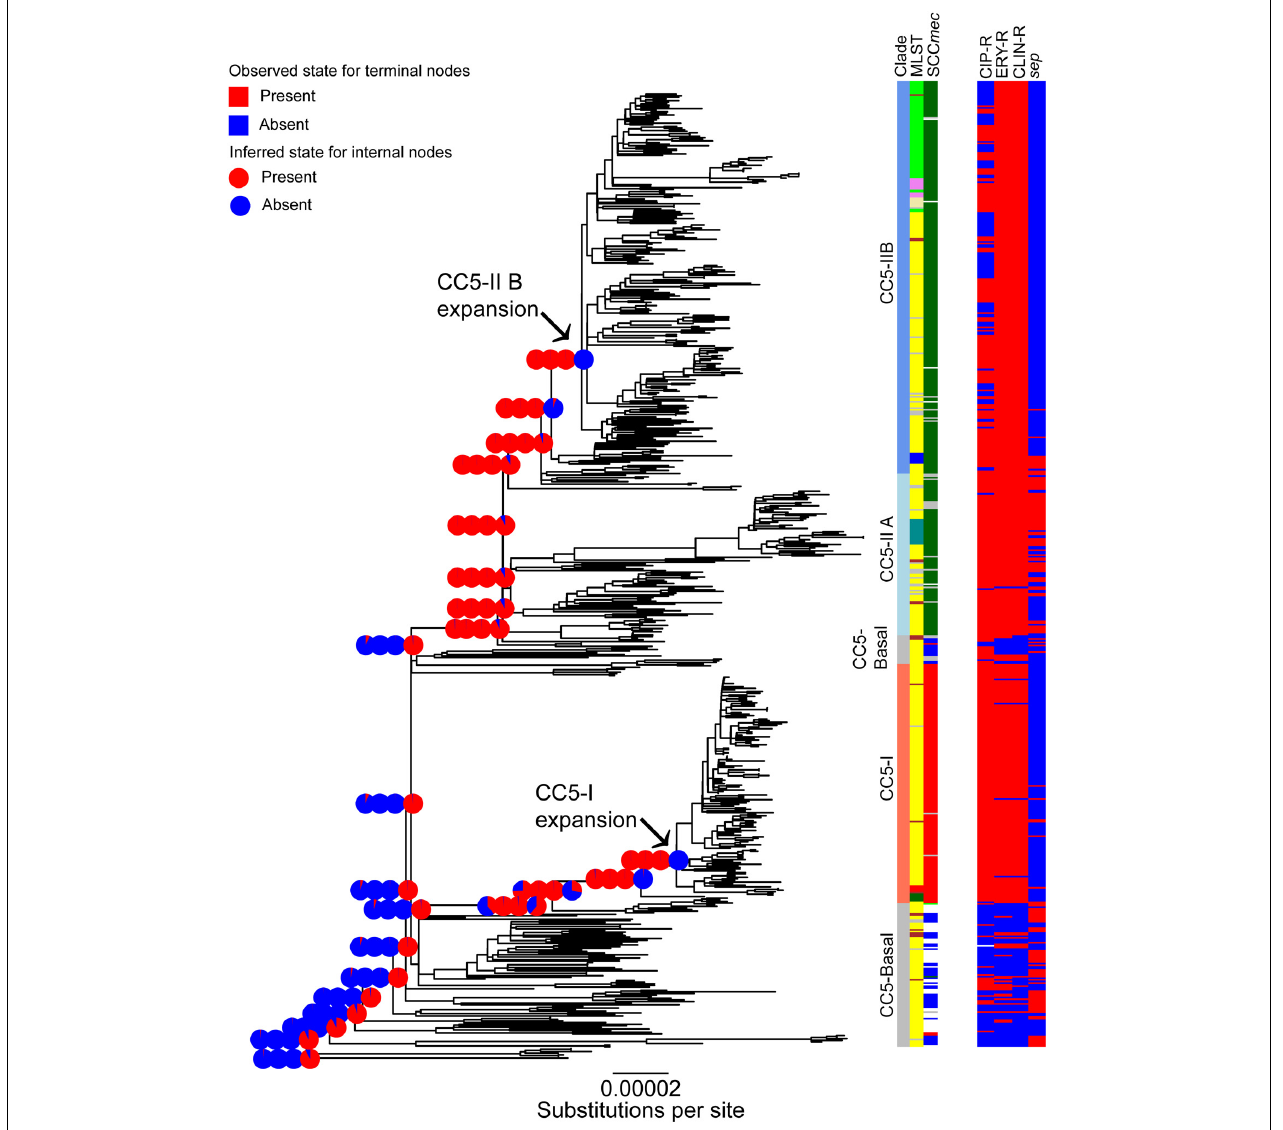
FIGURE 2 | Convergent evolution within CC5. The ML phylogeny of Figure 1 is shown. The major clades, multilocus ST, and SCC mec type are shown for reference purposes and colored as in Figure 1 . The CC5-I and CC5-II B expansion nodes are indicated with arrows. ML ancestral state reconstruction is shown along the phylogenetic backbone leading to the two expansion nodes; the four pie-charts at each of the backbone nodes indicate the likelihood of (in left-to-right order), fluoroquinolone, macrolide, and lincosamide resistance (red) or susceptibility (blue), and the presence (red) or absence (blue) of the sep toxin gene. Table adjacent to the tree indicates these traits in each genome. Scale bar indicates number of substitutions per